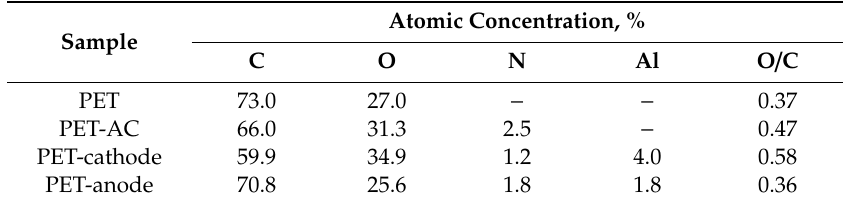
Table 2. Surface chemical structure of the initial and the plasma-treated (60 s) PET films.